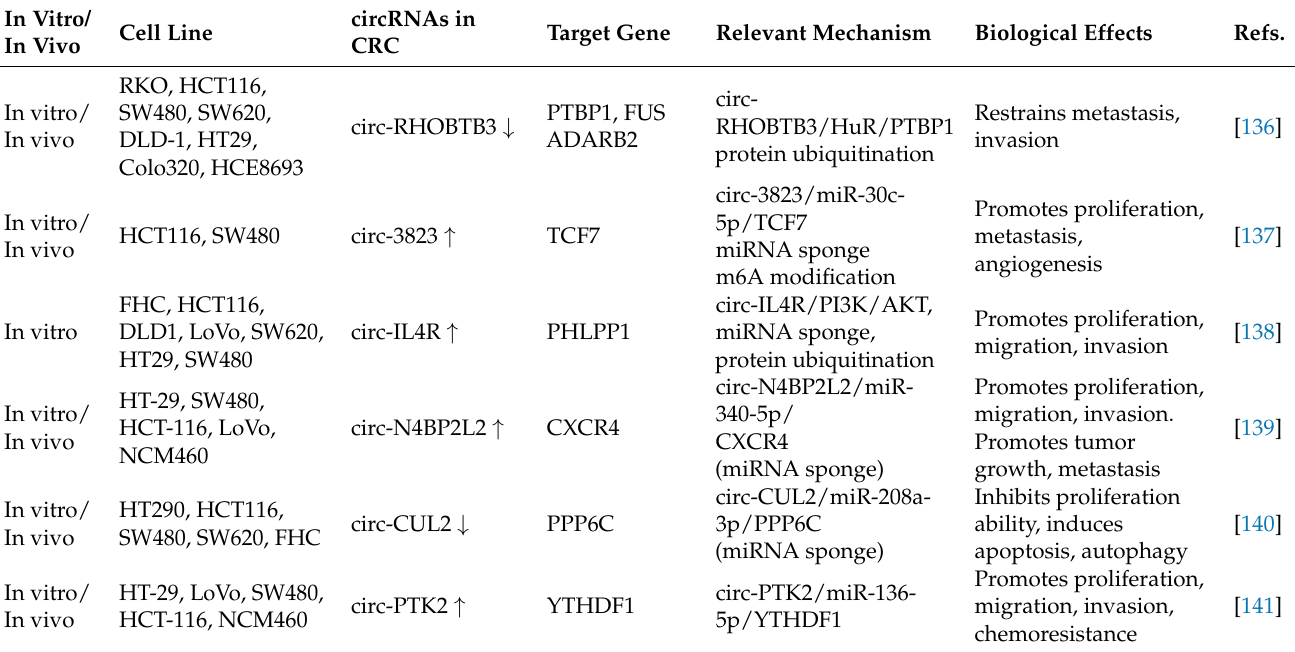
Table 4. Roles of circRNAs in colorectal